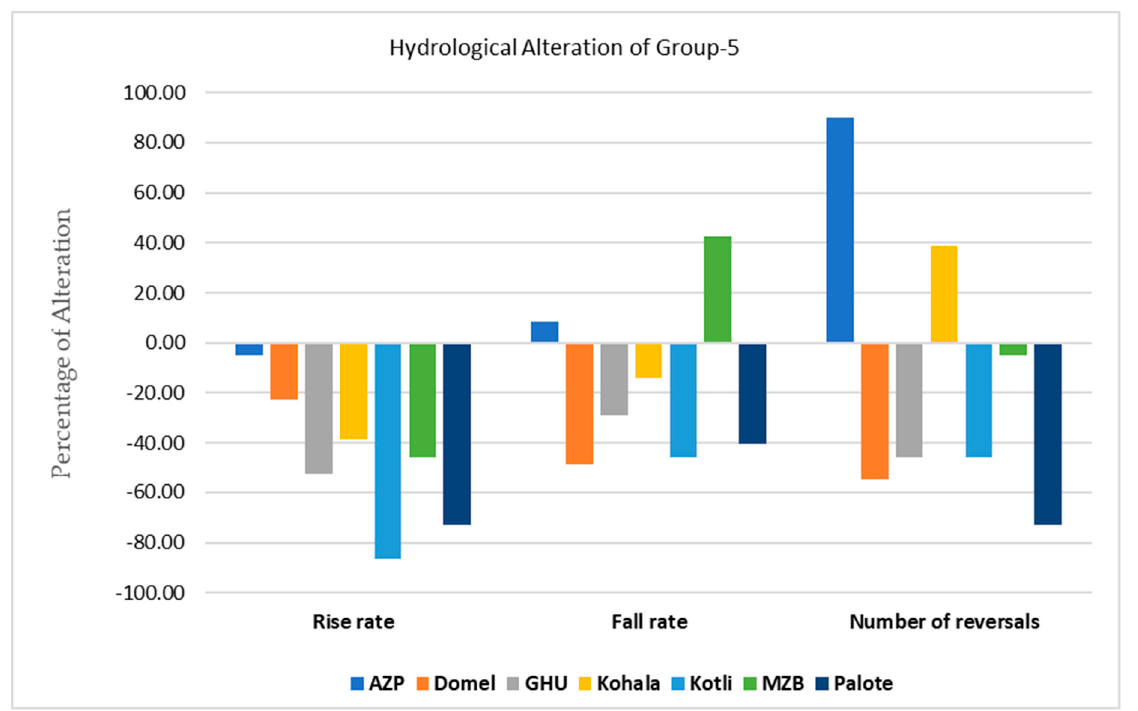
Figure 7. Hydrological Alteration of Group − 5